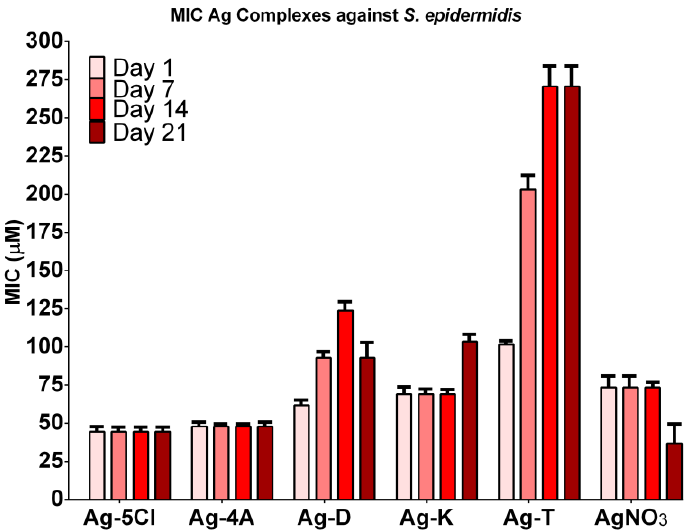
Figure 3. Antibacterial activity of Ag-complexes and AgNO3 against S. epidermidis over 4 weeks. Free ligand did not show antibacterial activity (MICs > 200 µg/mL).